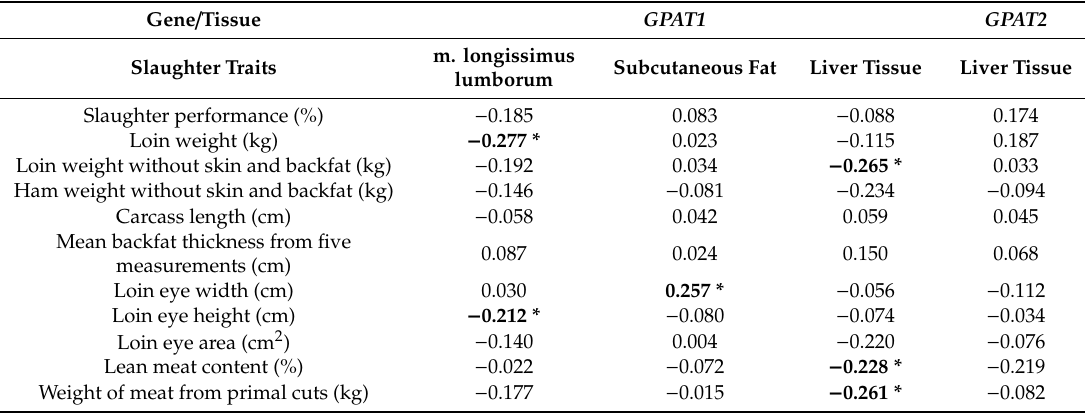
Table 2. Correlation between the expression level of the GPAT1 gene in m. longissimus lumborum, subcutaneous fat, liver tissue and the expression level of GPAT2 gene in liver tissue with slaughter traits (* p ≤ 0.05; ** p ≤ 0.01).